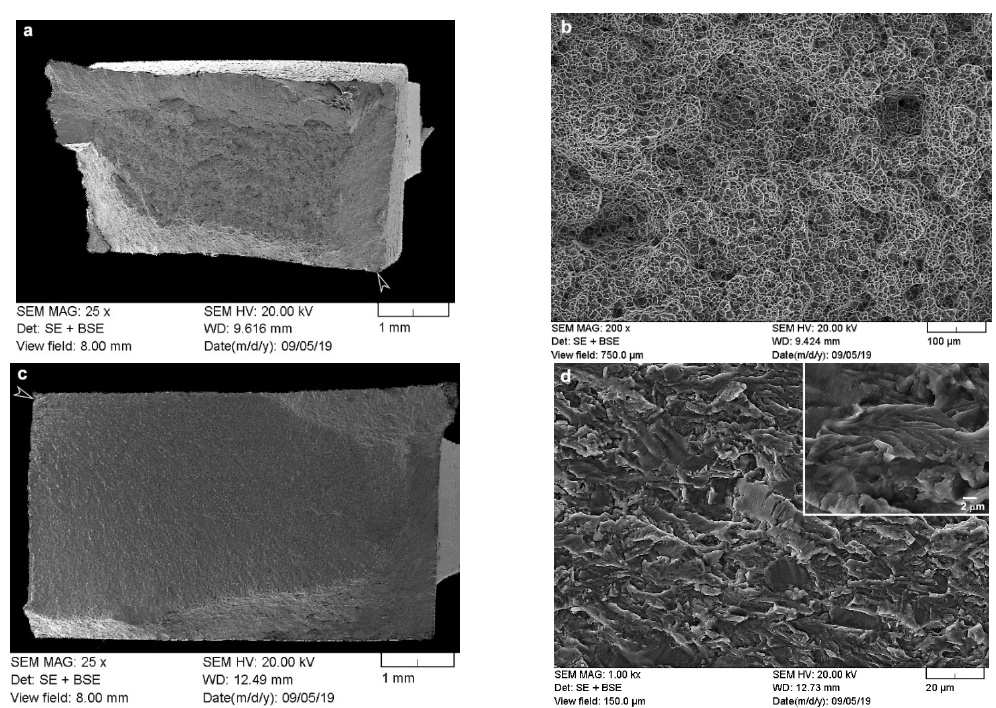
Figure 9. Fatigue fracture surface: ( a , b ) LCF overview image with the arrow indicating the failure initiation site and higher -magnification image showing the predominant tensile overload region (Ti64 BM) and ( c , d ) HCF overview image with the arrow indicating failure initiation site and higher-magnification image of the crack propagation area (Ti6242 BM) that shows the fatigue striations in the inset image.